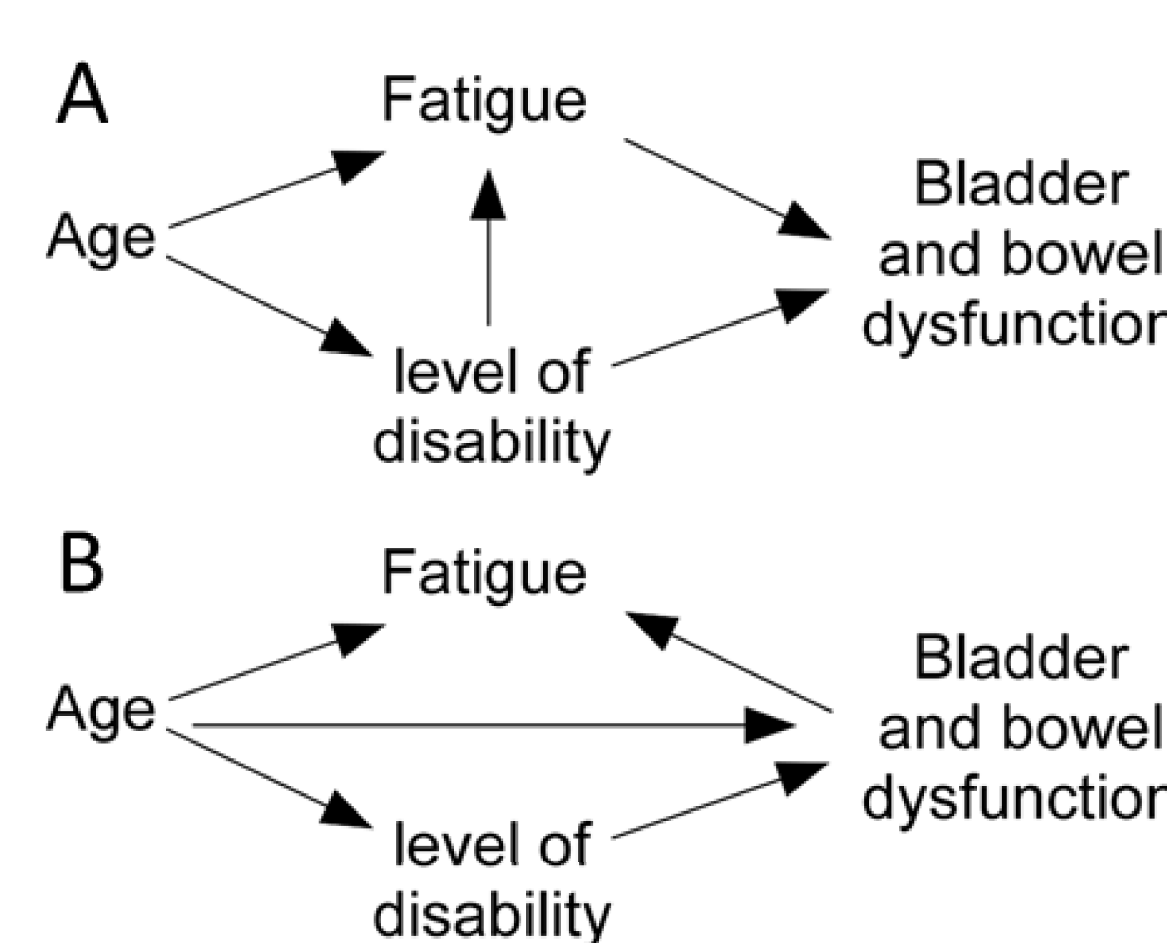
Fig 1. Causal directed acyclic graphs to determine variables that may need adjusting for in regressions designed to investigate the relationship between fatigue, level of disability (as measured by Expanded Disability Status Score), and bowel and bladder problems in people with Multiple Sclerosis. Fig 1A investigates the impact of fatigue and level of disability on bowel and bladder function, while Fig 1B investigates the impact of bowel and bladder dysfunction on fatigue.